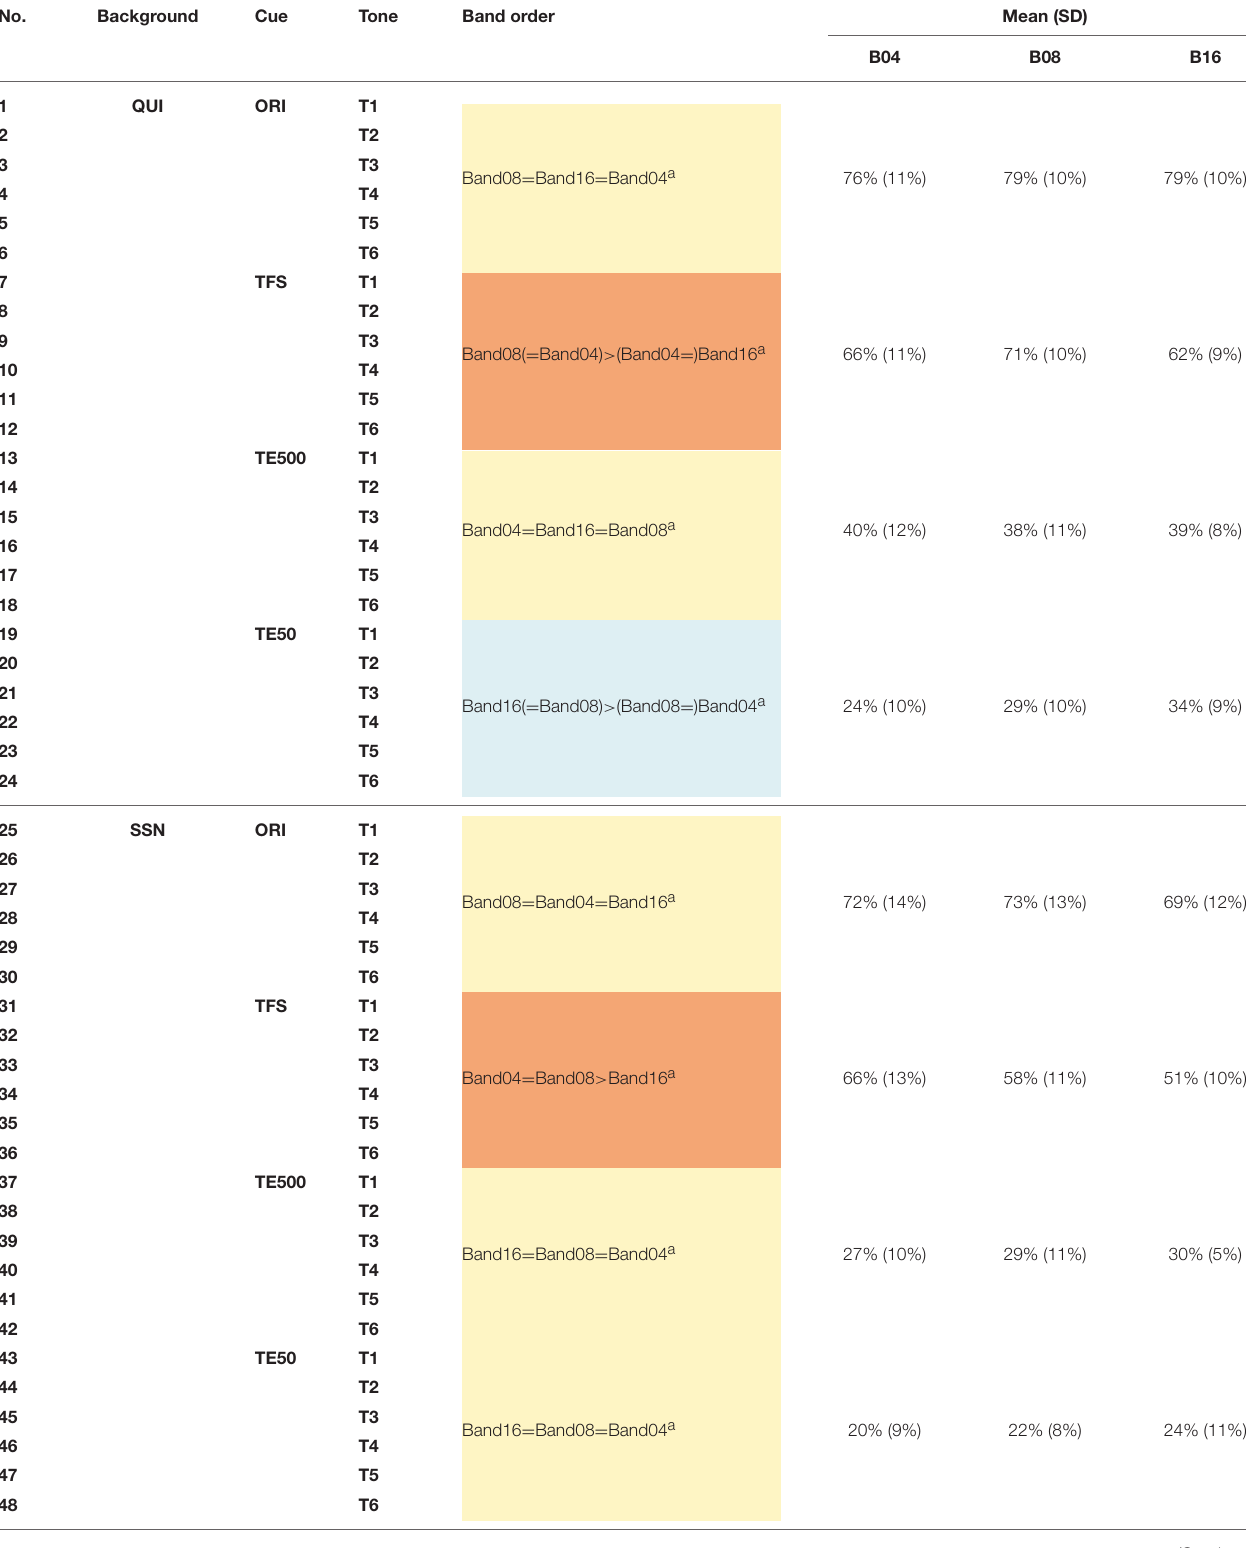
TABLE 7 | Results of pairwise comparisons in Cues * Bands * Tones three-way repeated measures ANOVA on tone accuracy by Backgrounds.